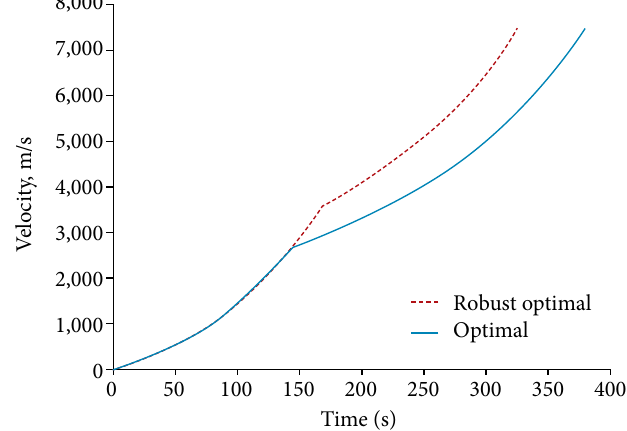
Figure 12. Comparison of speed in optimal and robust